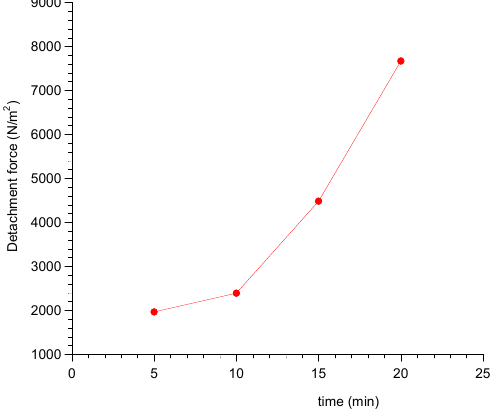
Figure 3. Exponential trend of detachment force of the patch as a function of contact time on porcine buccal mucosa.